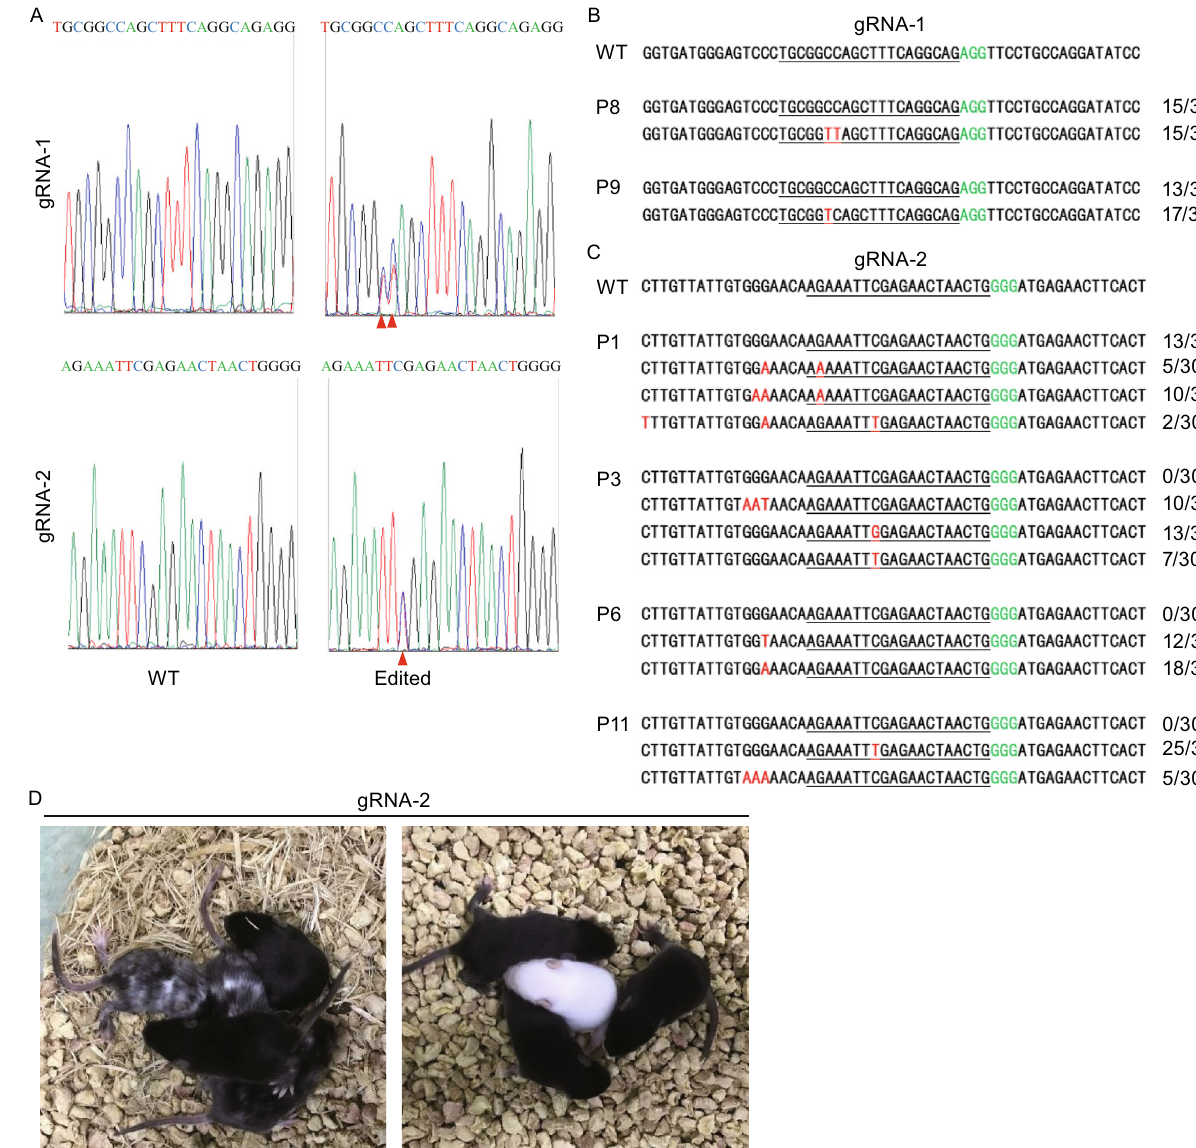
Figure 3. Generation of base-edited mice using HF2-BE2. (A) Representative sequencing chromatographs of the PCR amplicons of target sites from the founder mice are shown here. WT, wild-type embryo. Edited, embryo edited by HF2-BE2, with the successfully edited base indicated by red arrowheads. (B) PCR amplicons of gRNA-1 target sites from the genomic DNA of selected founder mice were subcloned into pGEM-T vectors and sequenced. The number of clones for each sequence pattern is indicated. Underlined, gRNA target regions. Green, PAM sequence. Red, point mutations. (C) PCR amplicons of gRNA-2 target sites from the genomic DNA of selected founder mice were subcloned into pGEM-T vectors and sequenced. (D) Founder pups (10 days old) from the gRNA-2